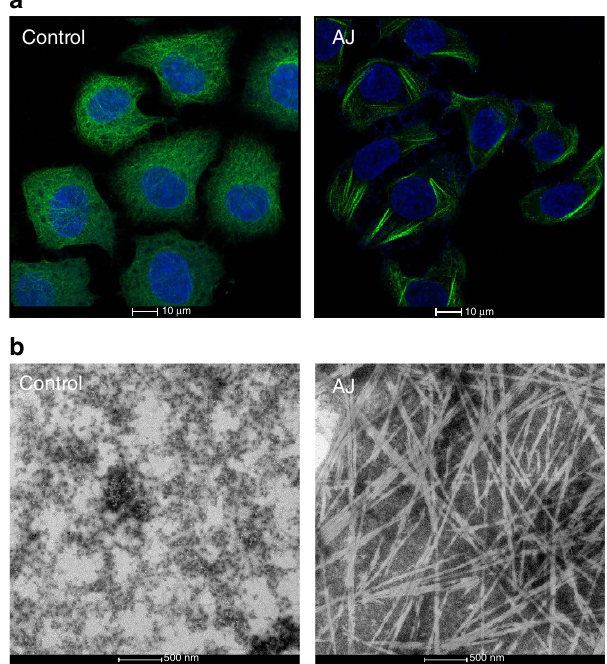
Figure 1 | Effect of AJ on tubulin oligomerization. ( a ) Immunofluore- scence confocal microscopy images of HepG2 cells treated with DMSO (control) or AJ. The nuclei and microtubules have been labelled with DAPI (blue) and a -tubulin antibody (green), respectively. ( b ) Transmission electron micrographs of negatively stained tubulin specimens obtained in the absence (control) and presence of